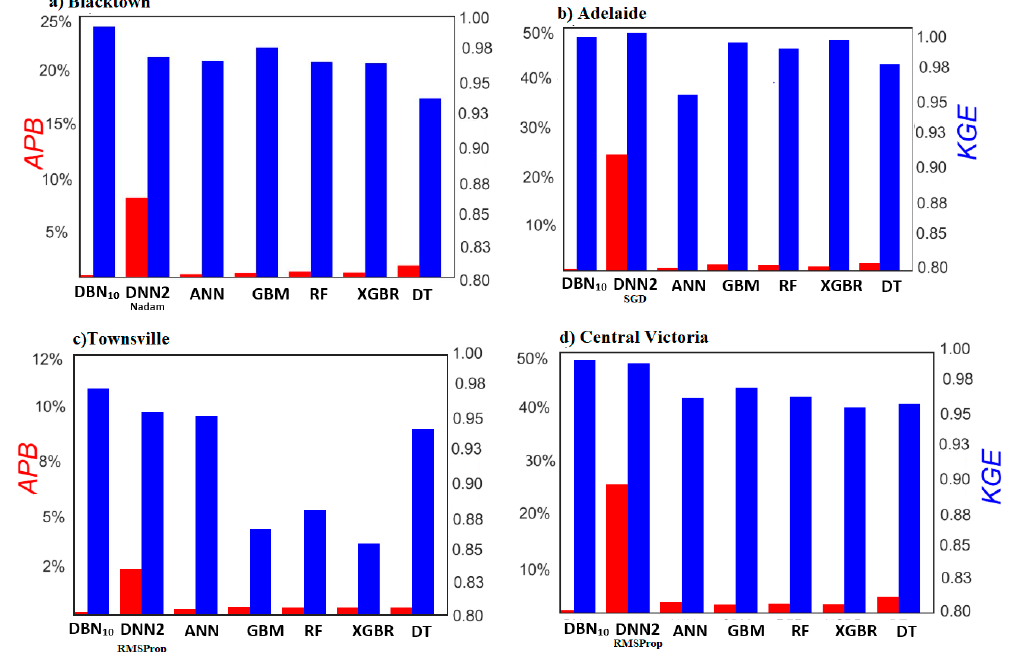
Figure 5. Bar chart showing a comparison of the optimal deep learning models ( i.e ., DBN 10 and DNN2 RMSProp ) in terms of their absolute percentage bias ( APB , %) and the Kling–Gupta efficiency ( KGE ) in the testing phase. For notations and model names, please refer to Table 1, Table 2, Table 3, Table 5 and Table 7).